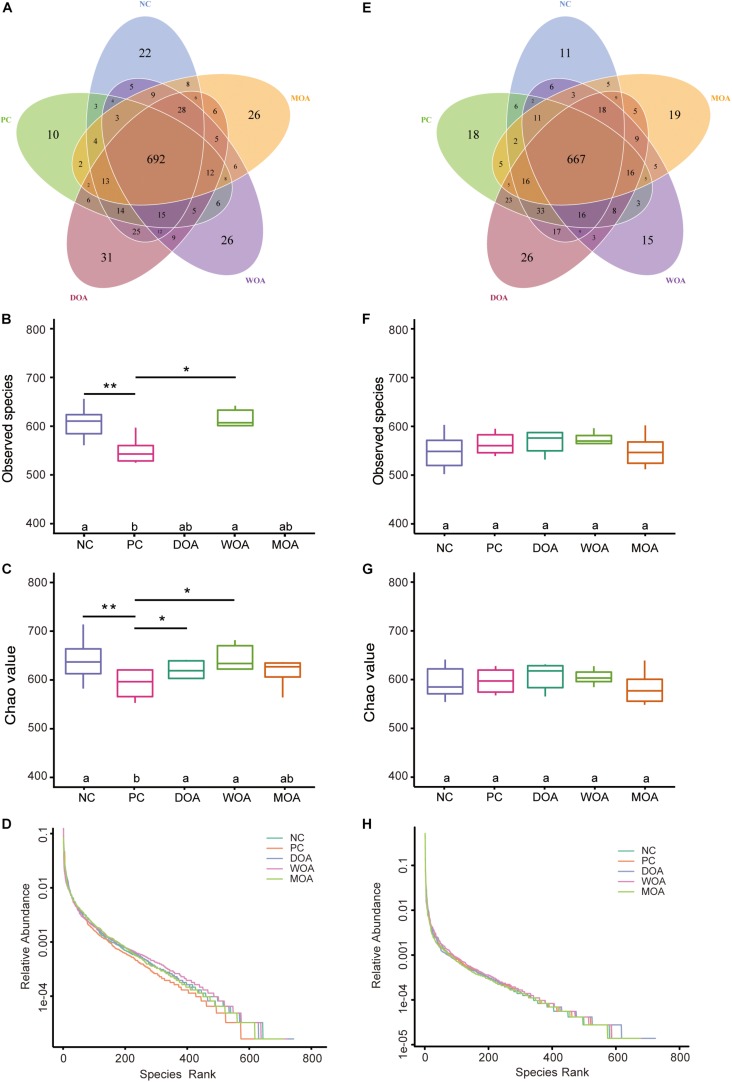
Alpha-diversity of the microbiome residing in the cecal chyme of broilers at the ages of 21 and 42 days. (A) Venn diagram at 21 days. (B) OTU values at 21 days. (C) Chao1 values at 21 days. (D) Rank abundance curves at 21 days. (E) Venn diagram at 42 days. (F) OTU values at 42 days. (G) Chao 1 values at 42 days. (H) Rank abundance curves at 42 days. In the Venn diagram, each circle represents one group, and the number of circles and circles overlapped represents the number of OTUs shared between the groups, while the number without overlap represents the number of OTUs unique to the group. The rank abundance curve is OTUs in the sample according to the relative abundance (or contain sequence number) in order of larger to smaller. To obtain the corresponding order number, take the abscissa of the OTU sort code, the relative abundance of OTUs as the ordinate, and connect these points with broken line, namely, drawing a rank abundance curve; it can intuitively reflect the richness and evenness of species in the sample. In the horizontal direction, species richness is reflected by the width of the curve; the higher the species richness is, the greater the span of the curve on the horizontal axis is. In the vertical direction, the smoothness of the curve reflects the evenness of species in the sample; the flatter the curve is, the more homogeneous the species distribution will be. NC, negative control, basal diet and basal drinking water with no antibiotic supplementation; PC, positive control, antibiotics supplementation; DOA, NC plus diet-administered OA supplementation; WOA, NC plus water-administered OA supplementation; MOA, NC plus diet-administered and water-administered OA supplementation. ∗ and ∗∗ indicates a significant difference at the 0.05 or 0.01 level between the two groups that were compared.